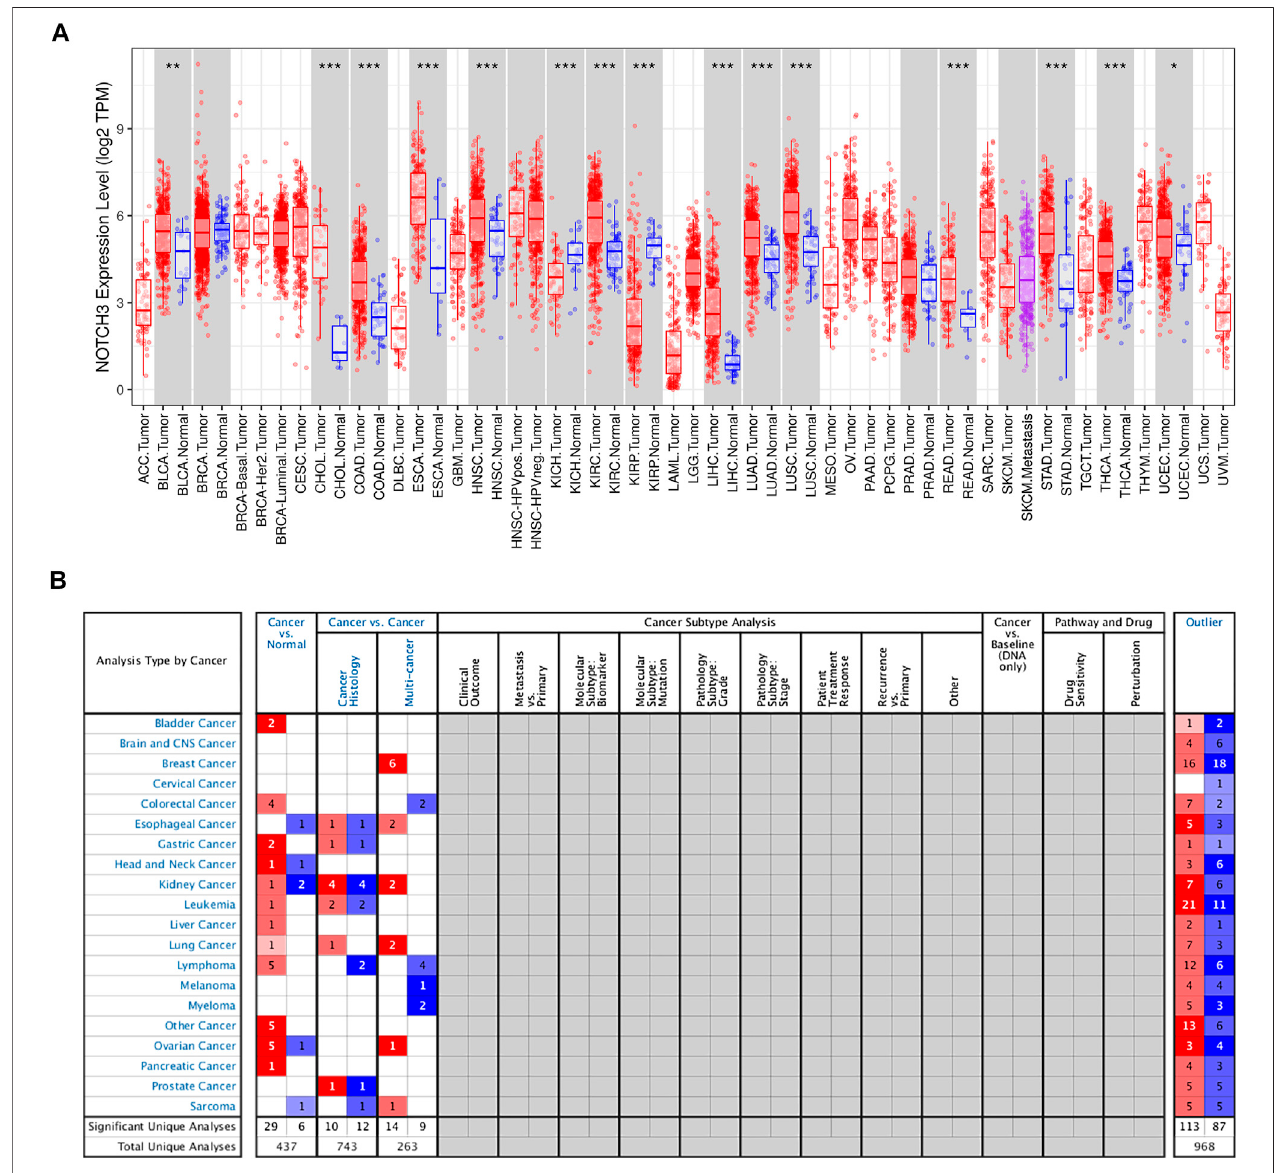
FIGURE 2 | The expression of Notch3 in human cancers. (A) The Notch3 expression levels of different cancer types in TCGA were determined using TIMER (https://cistrome.shinyapps.io/timer/) (* p < 0.05, ** p < 0.01, *** p < 0.001). (B) . Notch3 expression levels in different cancer types from the Oncomine database (www.